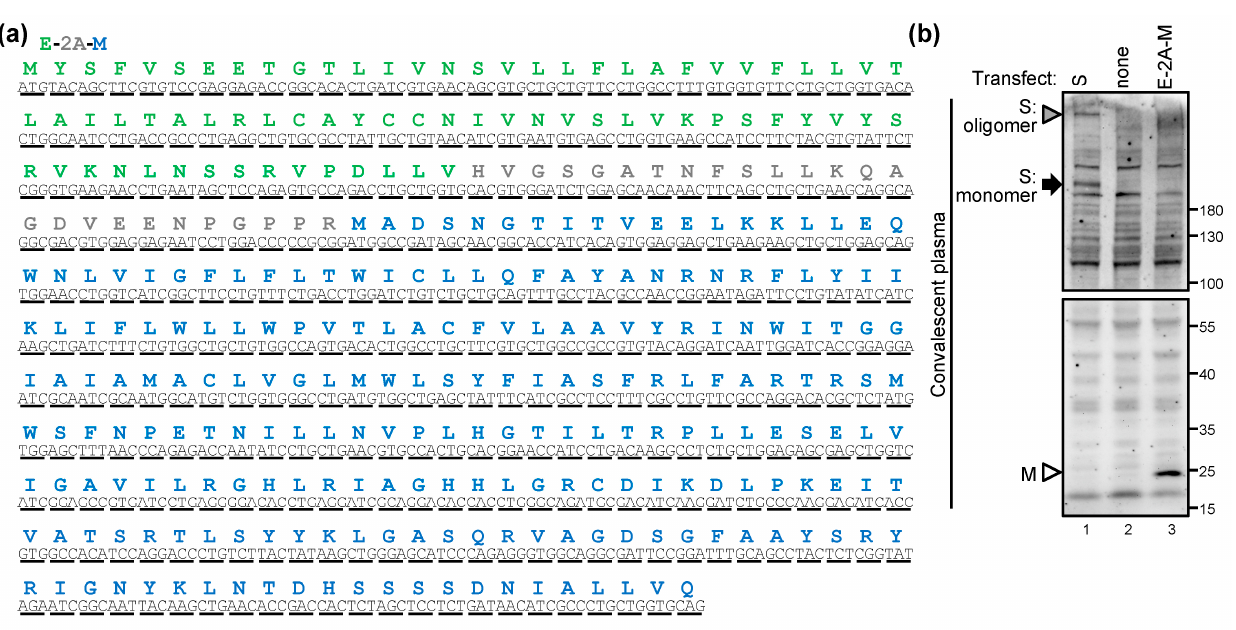
Figure 1. Protein expression of the SARS-CoV-2 structural proteins designed: ( a ) the sequence of the synthesized E-2A-M. ( b ) BHK-21 cells were transfected with SARS-CoV-2 S or E-2A-M as indicated, and the cell lysates were analyzed by Western blot (WB) using the convalescent human plasma. Black arrow, S monomer; gray triangle, S oligomer; white triangle, M.